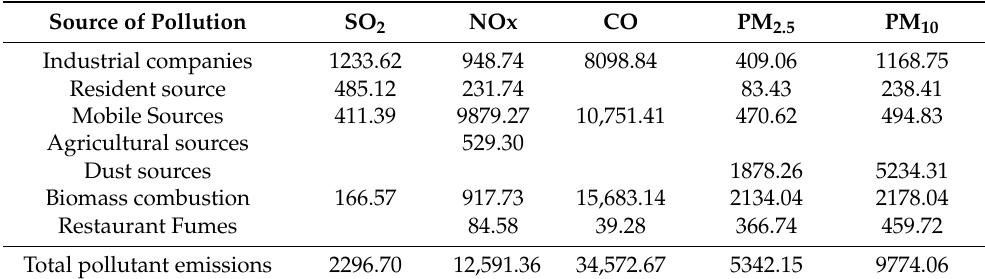
Table 4. Xishuangbanna State Air Pollution Inventory for 2021. Unit: ton.